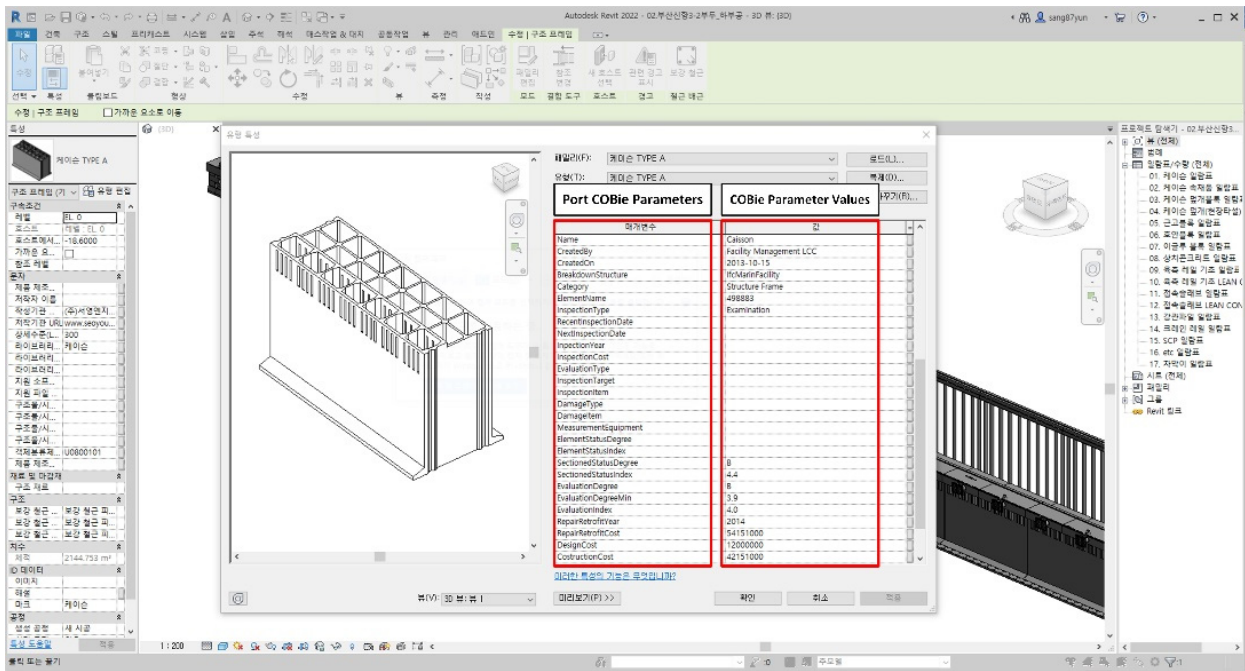
Figure 17. Port BIM model after COBie data input.